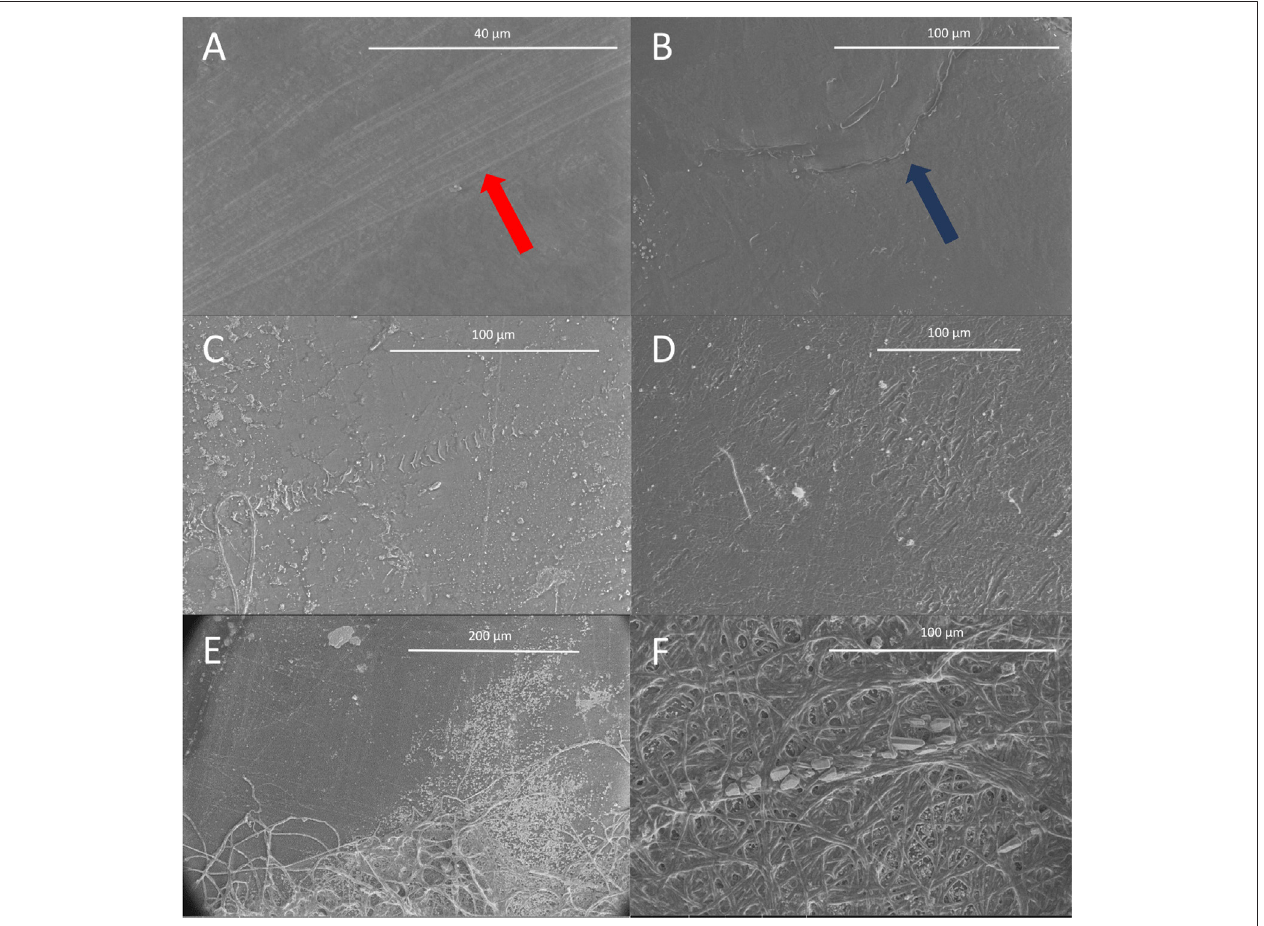
FIGURE 4 | E-SEM micrographs of reference (A,B) and exposed (C – F) LDPE fi lms.